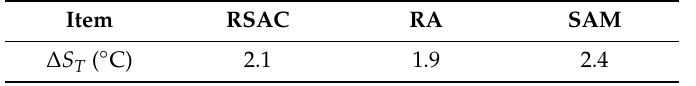
Table 5. The results of storage